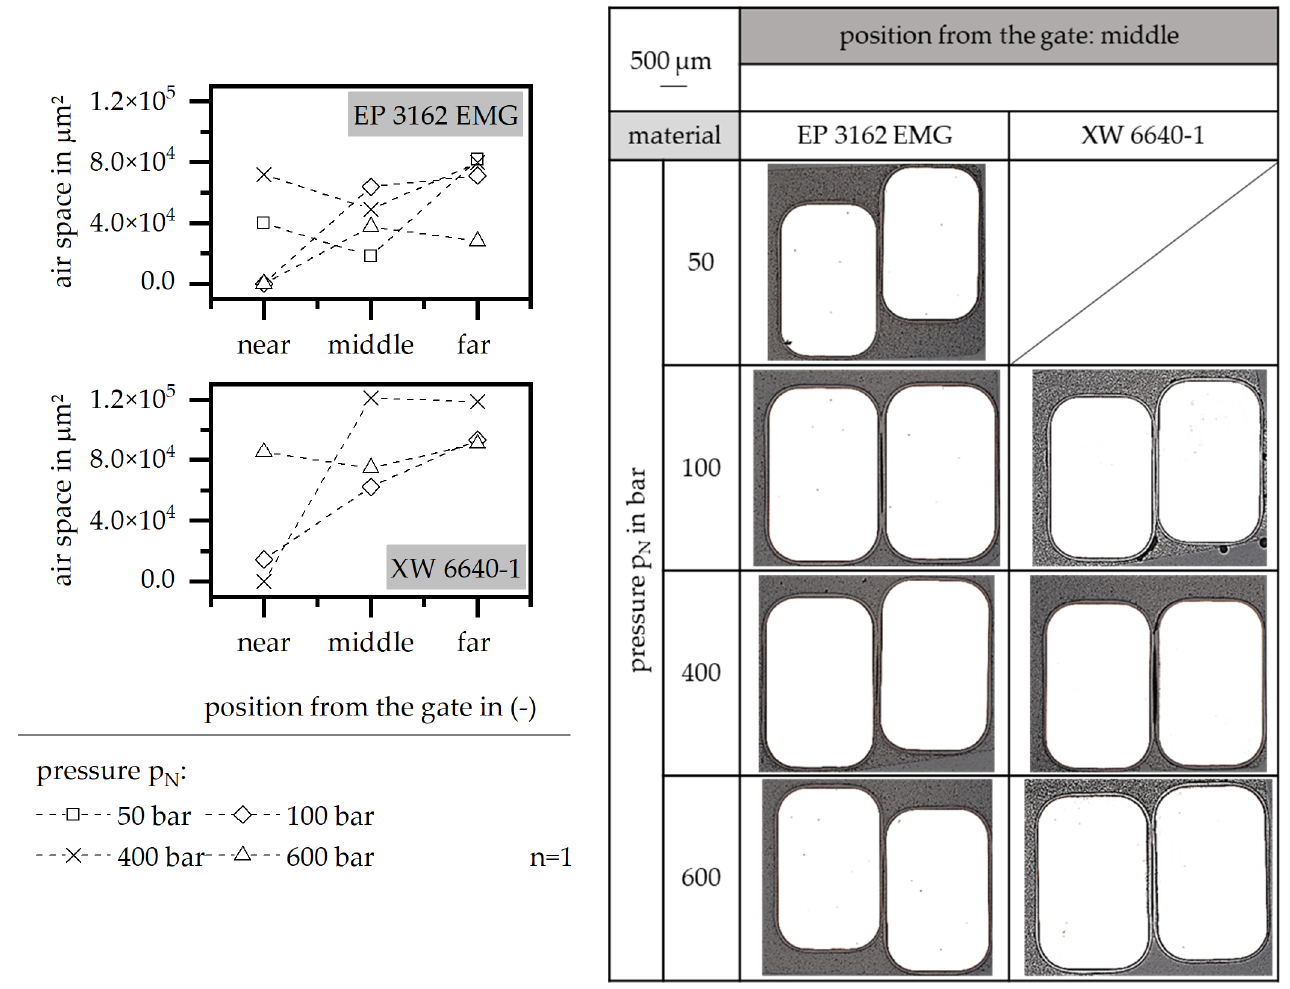
Figure 12. Airspace and position of the wire relative to the stack, relative to the holding pressure in the insulation system. the insulation